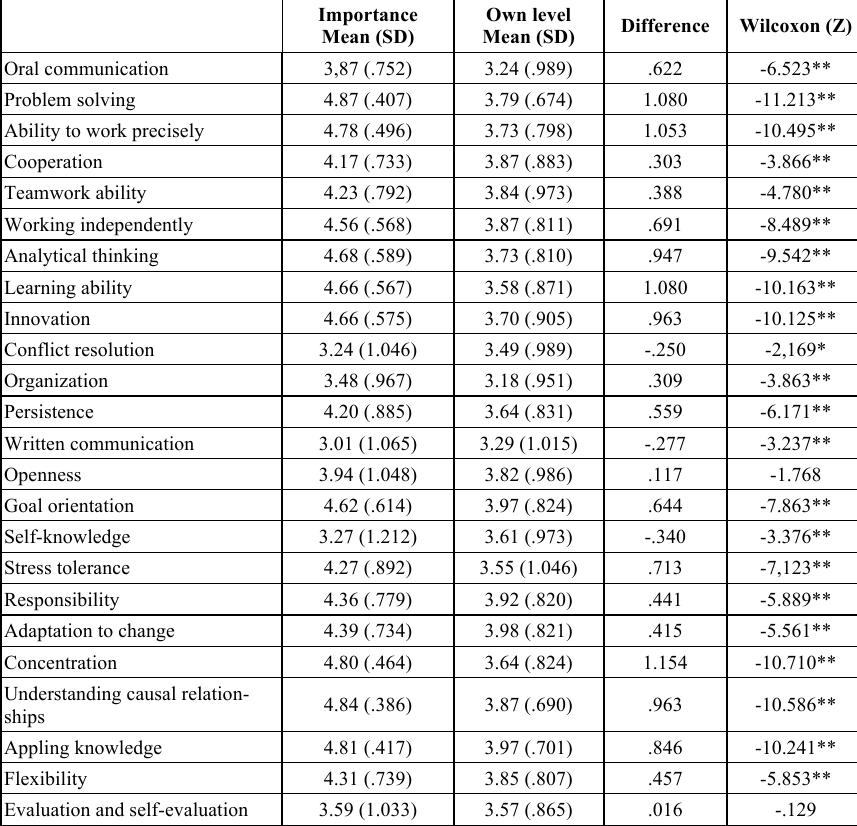
Table 2. Means, standard deviations (SD) and differences between the perceived importance and self-reported proficiency level of